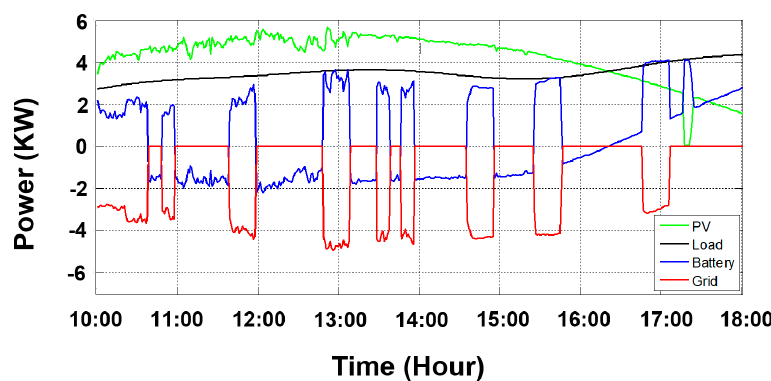
Figure 9. Rule-based EMS: power management of the hybrid system.